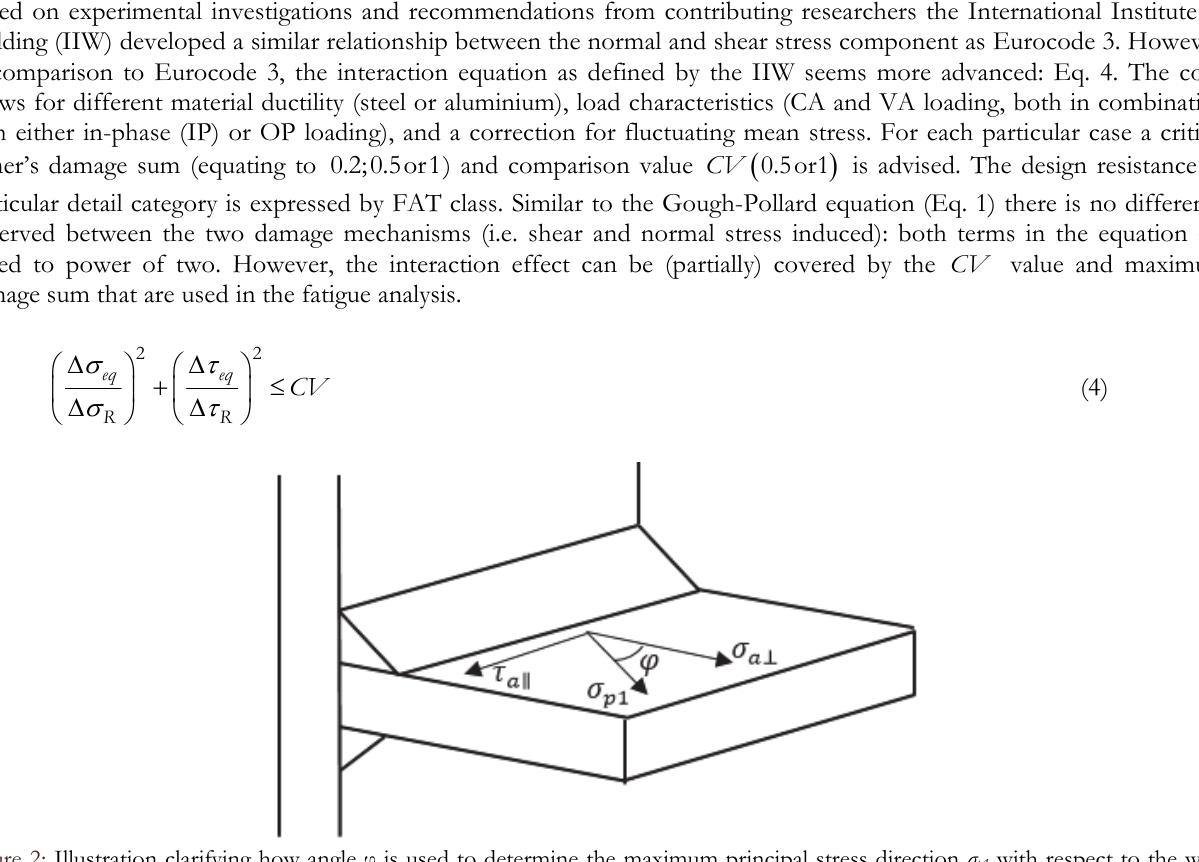
Figure 2: Illustration clarifying how angle φ is used to determine the maximum principal stress direction σ p1 with respect to the weld toe; Reproduced from